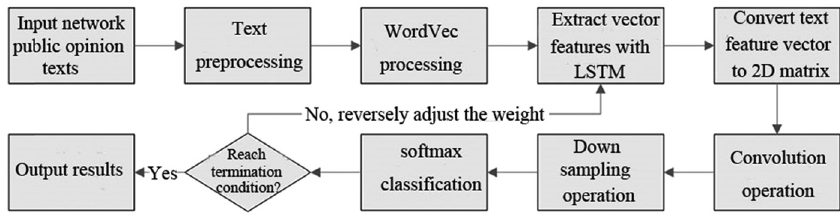
Figure 4: The training process of online public opinion emotion tendency classi fi cation model based on the LSTM - improved CNN